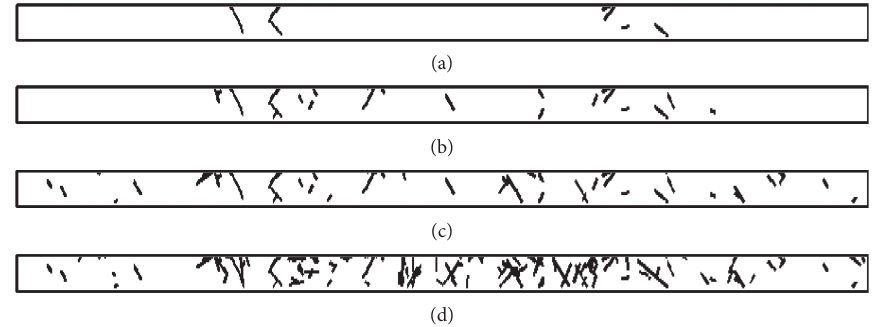
Figure 6: Evolution of the fracture network in the coal seam in vertical section plane 3: (a) 150m from the mining face; (b) 100m from the mining face; (c) 50m from the mining face; (d) at the mining face.